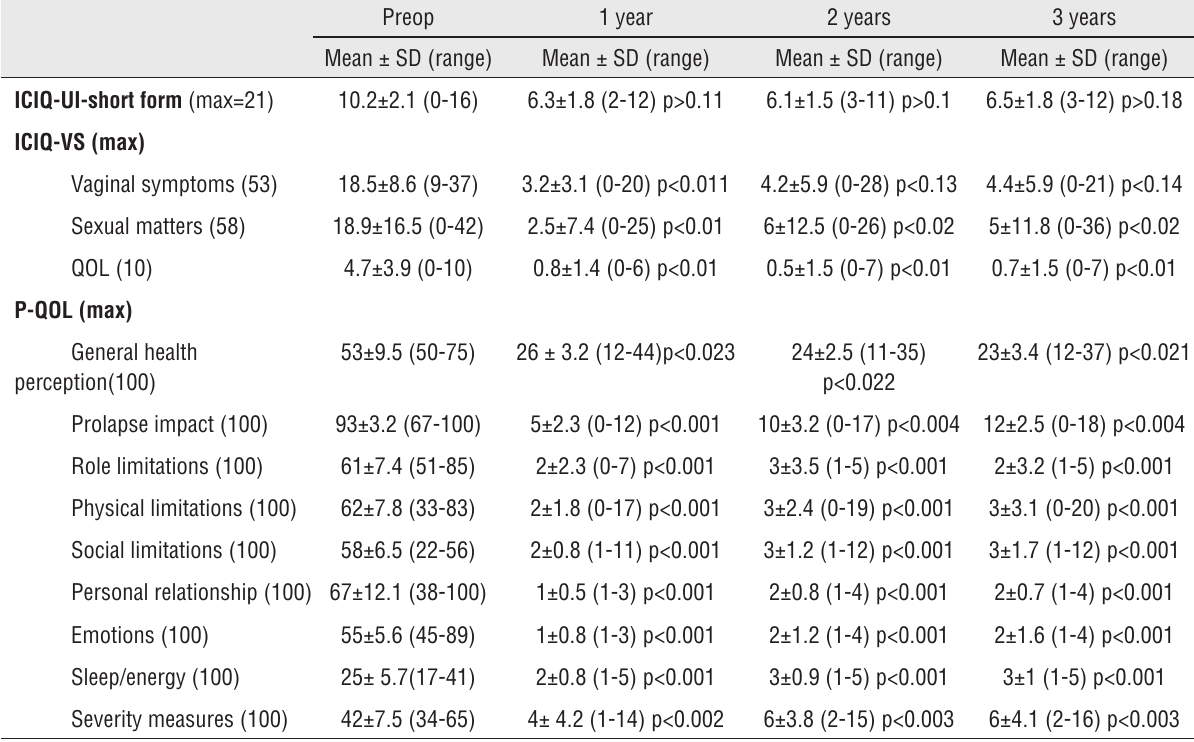
Table 3 - subjective IcIq-uI short form, IcIq-vs and p-qOL outcomes at baseline and after AEs